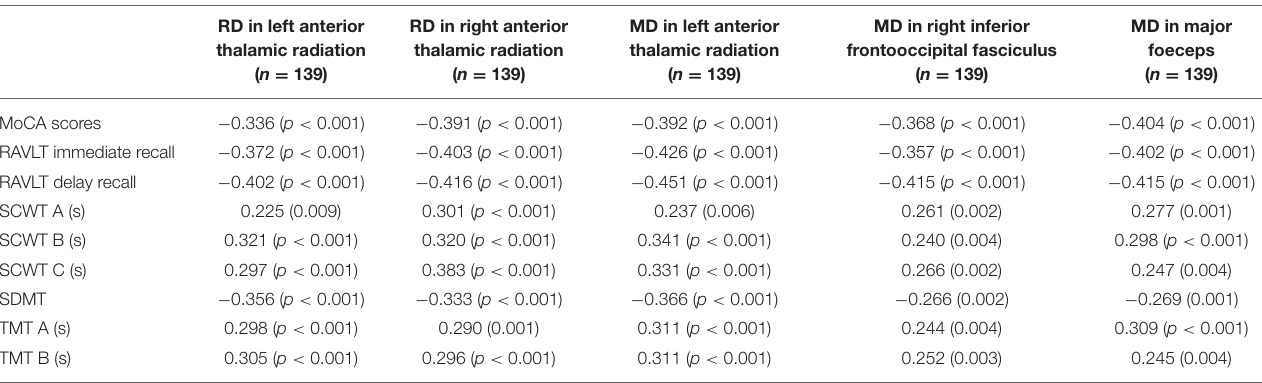
TABLE 3 | Correlation analysis between DTI parameter metrics and cognition scale